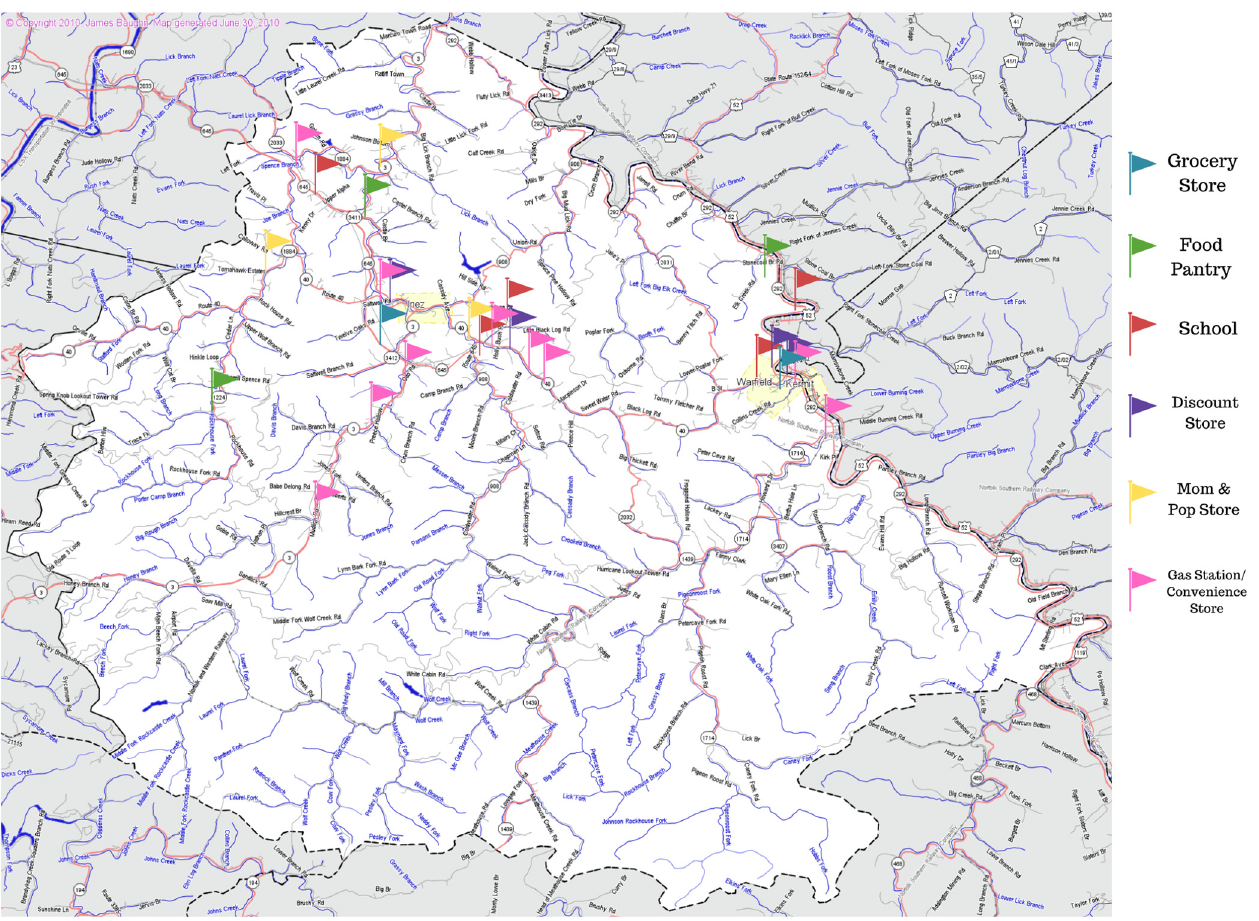
Figure 1. Map of Martin County, KY (229 sq. miles) with all available food outlets available to the residents within the county designated.